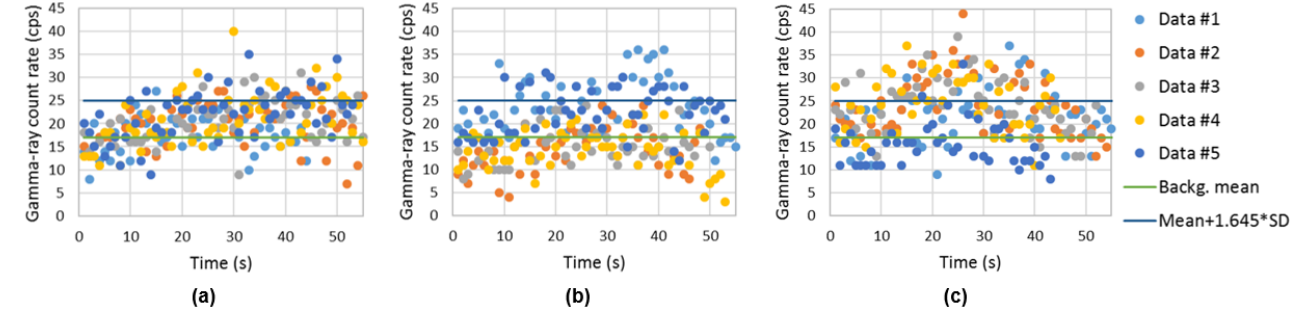
Figure 21. EJ-200 scintillator gamma-ray count rate (cps) measurements obtained using the detection system integrated in the drone considering 137 Cs sources of 4 MBq positioned at the center of the container. The distance “D” between the real sources position and the estimated position (MLE algorithm) is also given. Drone trajectories were performed at: ( a ) one-third the container height. ( b ) half the container height. ( c ) two-thirds the container